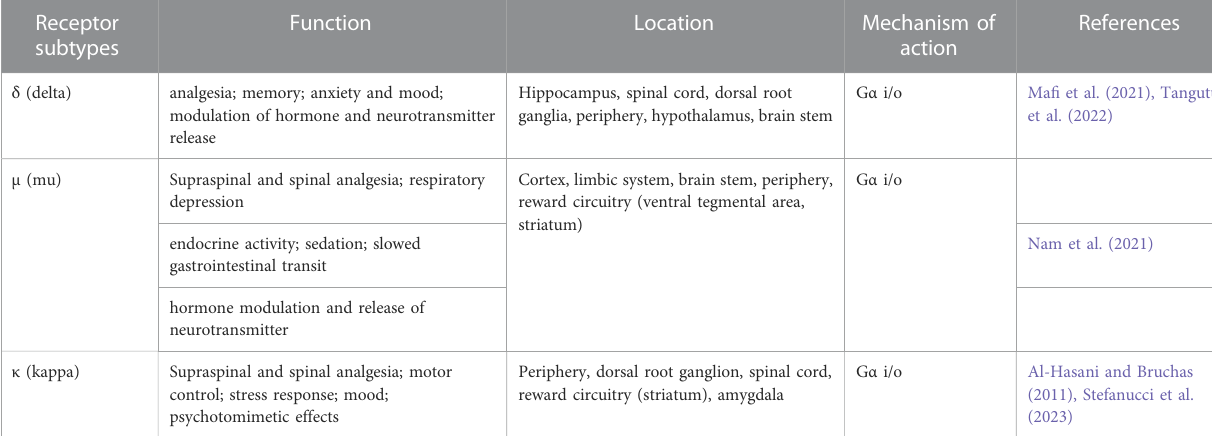
TABLE 1 Opioid group receptor subtypes, function & location in brain.